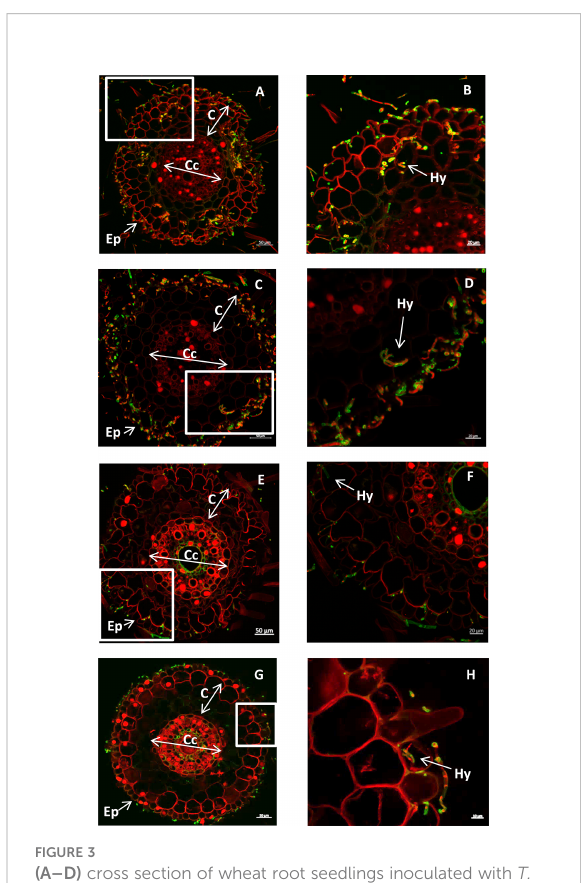
FIGURE 3 (A – D) cross section of wheat root seedlings inoculated with T. guizhouense (A, B) or T. afroharzianum (C, D) using the PDA inoculation method. E-H: cross section of wheat root seedlings inoculated with T. guizhouense (E, F) , with T. afroharzianum (G, H) using the spore inoculation method. (Ep) epidermis, (C) cortex (Cc) central cylinder, (Hy) fungal hyphae. The fungal hyphae are stained green using WGA-Alexa Fluor 488, and the root cell walls are stained red using propidium iodide, (BDFH correspond to the boxes of ACEG